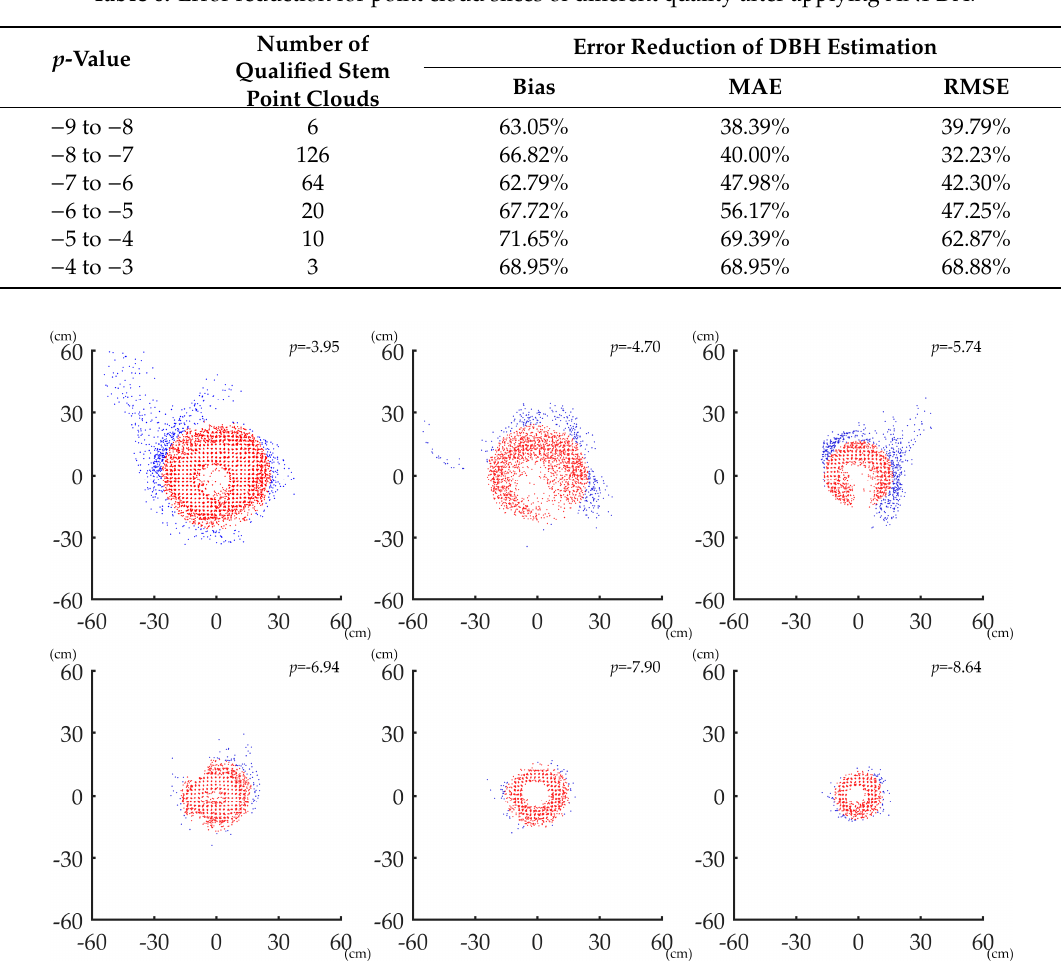
Table 6. Error reduction for point cloud slices of di ff erent quality after applying ANPDA.